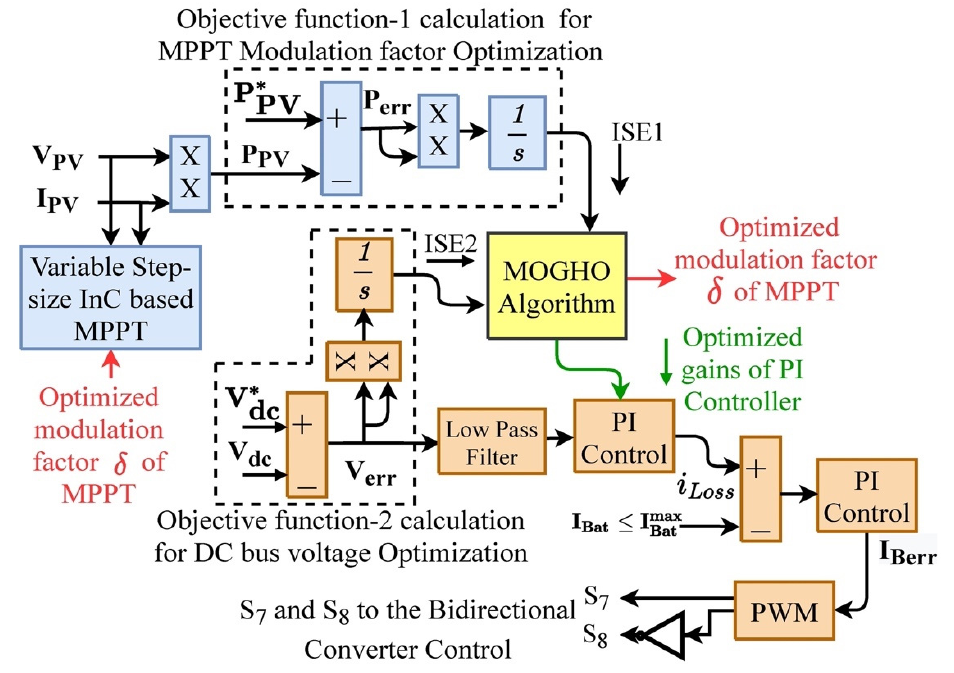
Figure 6. Bi-directional converter and DC bus voltage control.